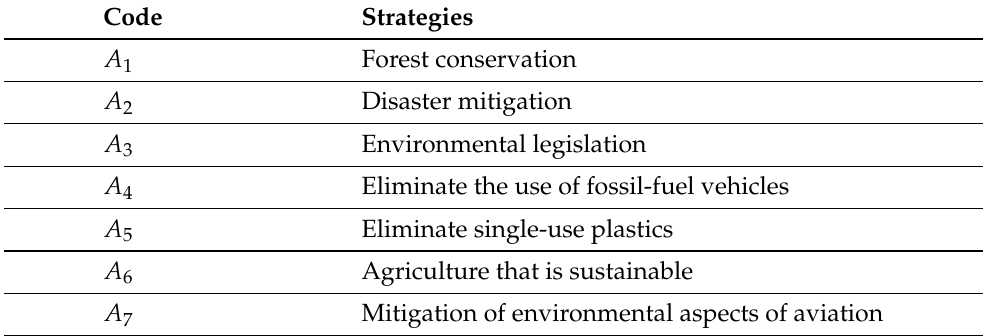
Table 5. Strategies for environmental